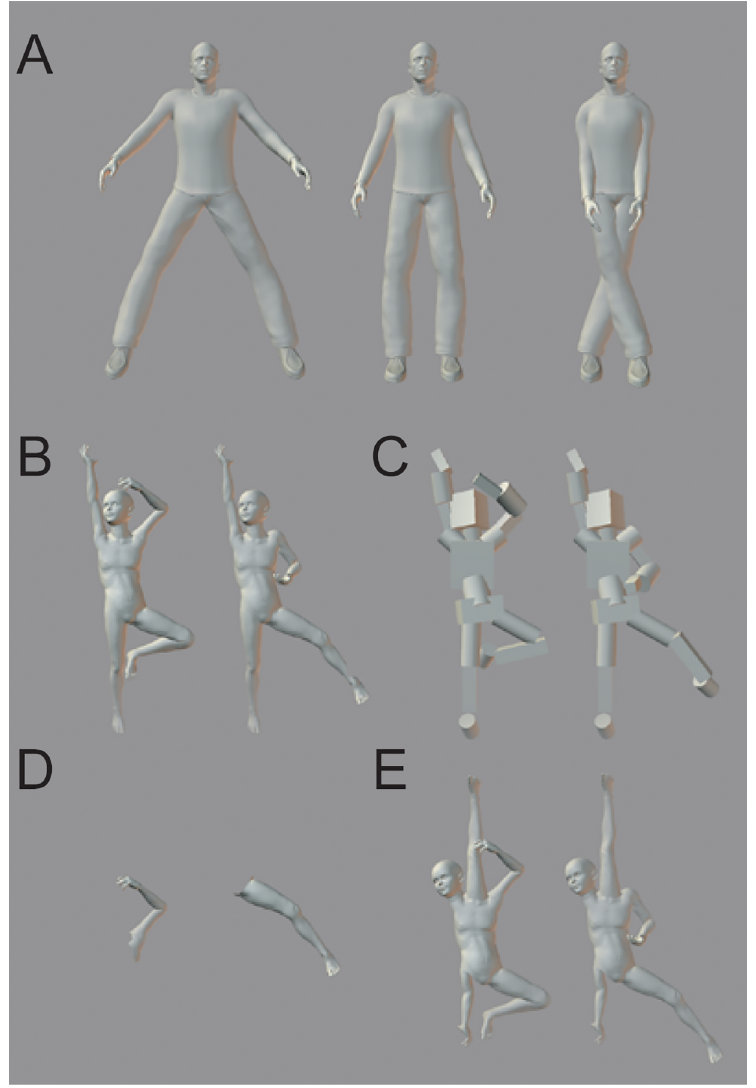
Fig 1. Examples of upright stimuli used in the experiments. (A and B) Whole body postures. (C) Cubic/cylindrical body postures. (D) Part body postures. (E) Scrambled body